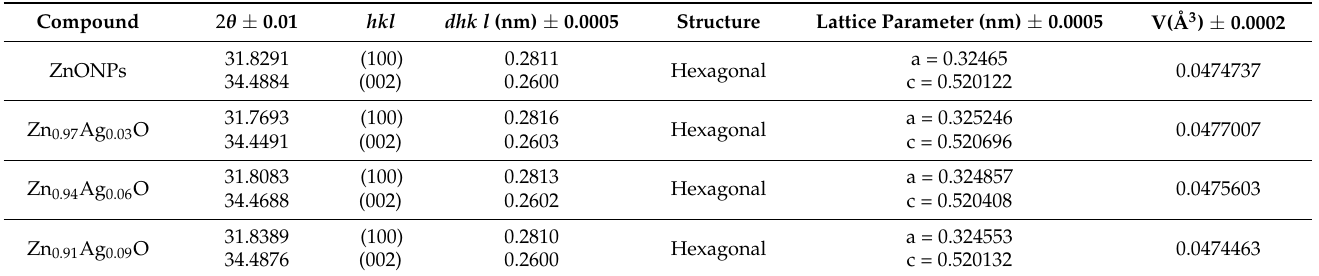
Table 1. The numerous combinations of ZnO and the Ag-doped XRD peak, lattice parameters, and their crystal structure and volume.